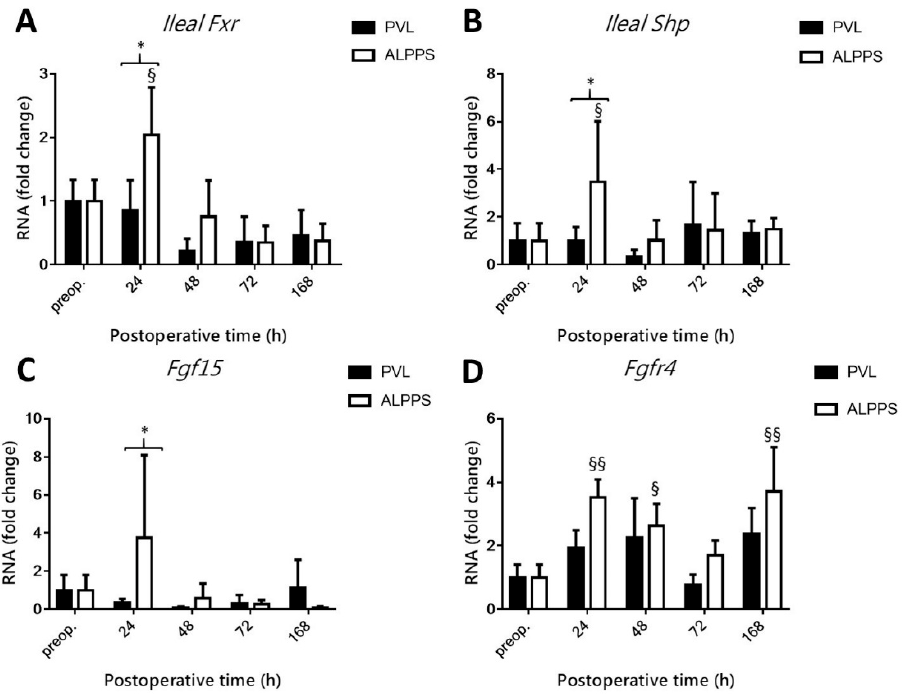
Figure 8. Effect of portal vein ligation (PVL) and associating liver partition and portal vein ligation for staged hepatectomy (ALPPS) on the intestinal Fxr pathway. Intestinal Fxr ( A ), intestinal Shp ( B ), Fgf15 ( C ), and Fgfr4 ( D ) were determined preoperatively (preop.) and at 24 h, 48 h, 72 h, and 168 h after PVL and ALPPS ( n = 6 per time point per group). * p < 0.05; § p < 0.05, §§ p < 0.001 ALPPS versus corresponding controls (preop.). Statistical analysis was performed with a two ‐ way ANOVA and Tukey’s post hoc test. Data are presented as mean ± 1 standard deviation (SD).